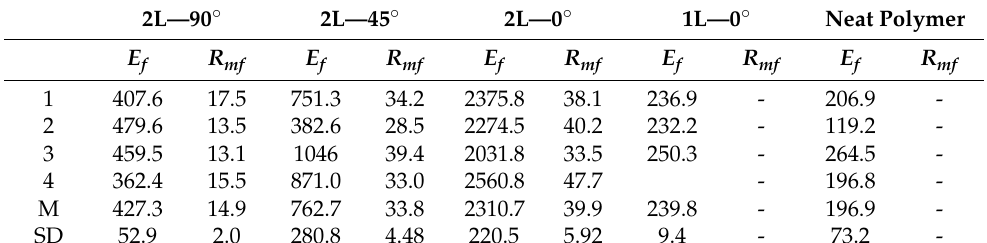
Figure 3. Results of flexural bending tests on composite reinforced with a double layer of fibers in three directions: ( a ) in the 90 ◦ , ( b ) in the 45 ◦ direction and ( c ) in the 0 ◦ direction, with respect to UD fibers orientation (four samples tested for each direction, each data set is presented with a different symbol). Table 3. Flexural modulus E f and flexural strength R mf of the four samples of the double layer (2L) composite cut in three directions with respect to the fibers orientation and the modulus for single layer (1L) composite and for neat polymer samples. All values are in MPa.